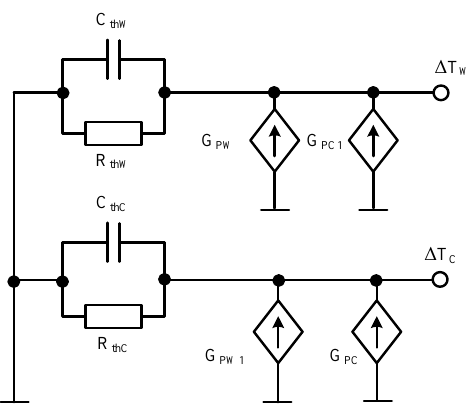
Figure 2. Network representation of the thermal model of magnetic components from [18].